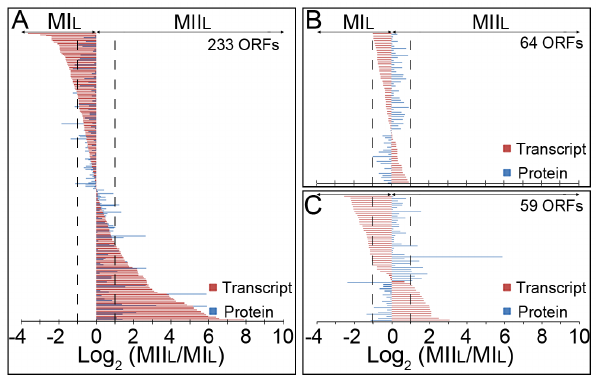
Figure 3. Comparison between transcriptomics (this work) and proteomics [ 12 ] . Transcription and protein abundance values correspond to log2 MIIL/MIL and are the average of two (in the case of proteomics) or three (in the case of transcriptomics) biological replicates. Dashed lines indicate the limit for considering abundance variations as significant (log2 abundances greater than 6 1). (A) Proteins and transcripts significantly up-regulated in MIIL (positive abundance values higher than 1) or in MIL (negative abundance values lower than 2 1). (B) Proteins and transcripts without significant variations (log 2 abundances within 6 1 interval). (C) Proteins and transcripts showing divergent abundance values (positive values in MIL and negative in MIIL or vice